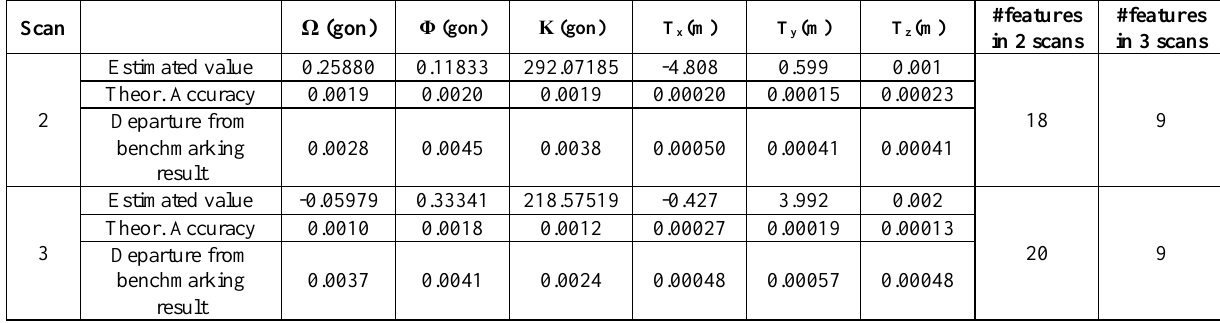
Table 4. Statistical results for ‘Office room’ data